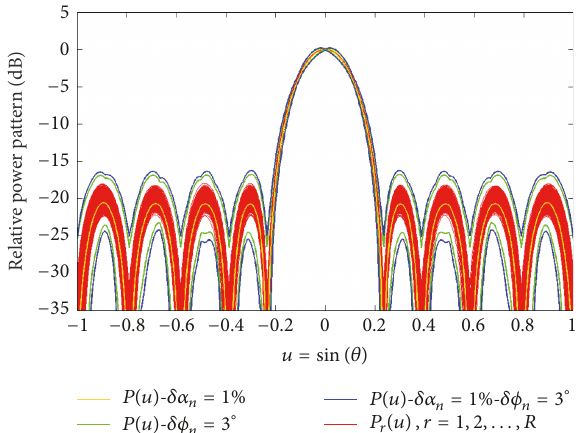
Figure 2: Bounds of the power pattern 𝑃(𝑢) based on IA with 𝛿𝛼 𝑛 = 1 %, 𝛿𝜑 = 3 ∘ . 𝑛